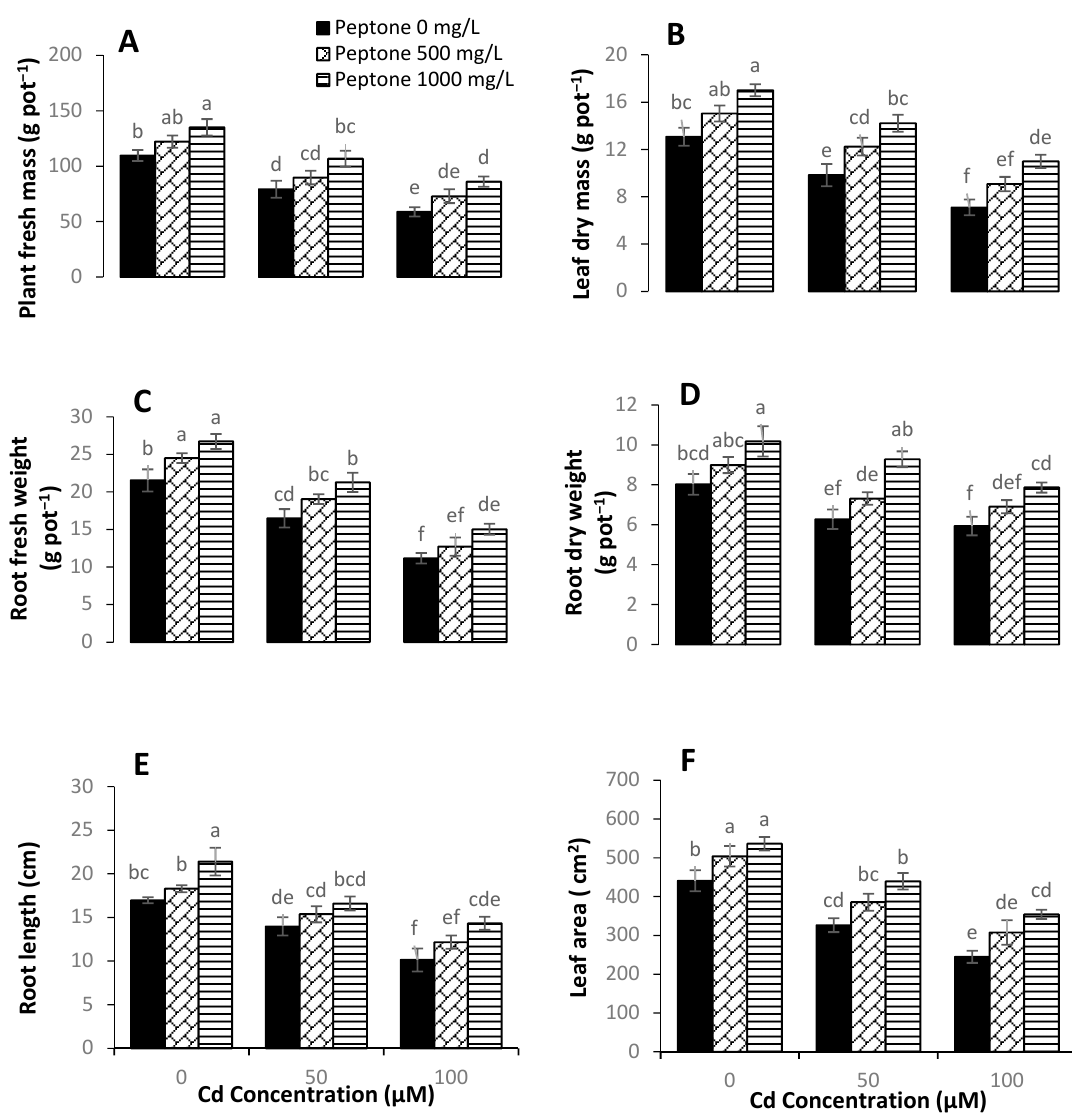
Figure 1. The influence of the foliar application of peptone (0, 500, and 1000 mgL − 1 ) on the leaf fresh weight ( A ), leaf dry weight ( B ), root fresh weight ( C ), root dry weight ( D ), taproot length ( E ), and leaf area ( F ) of spinach plants grown under Cd stress. Values represent the means of four replicates with standard deviations. Letters on the bar indicate the significant differences between given treatments at p < 0.05.